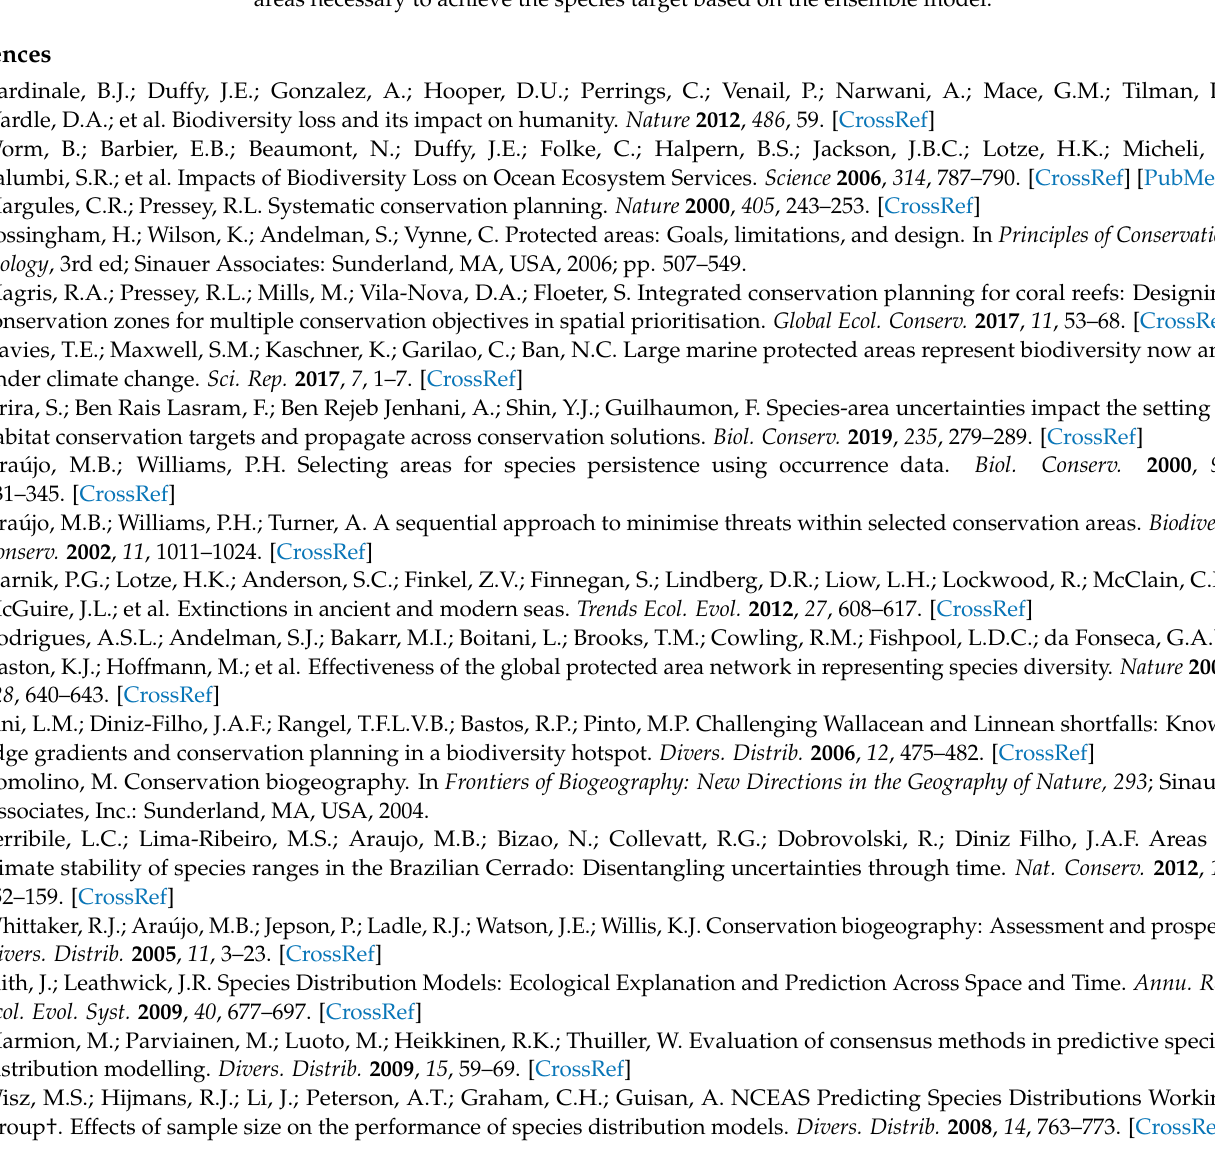
Figure A4. Conservation outcomes following the post-selection approach. Map of priority ranking values across optimal solutions built for each ‘distribution scenario’. Boxplot of the percentage of protected areas across those optimal solutions. The grey point represents the percentage of protected areas necessary to achieve the species target based on the ensemble